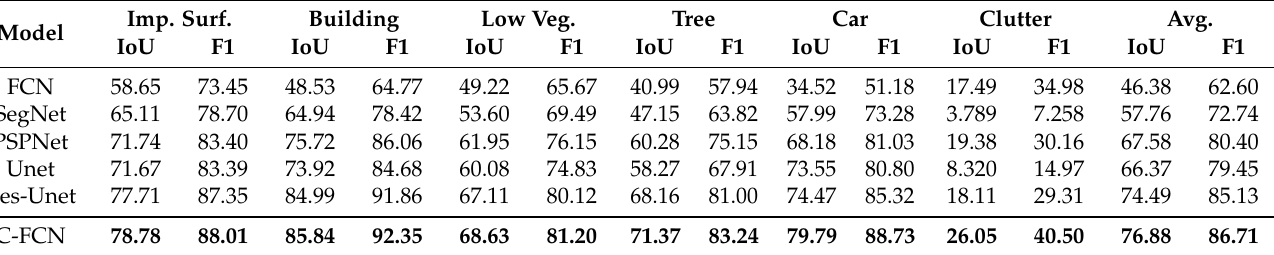
Table 5. Quantitative comparison (%) with baseline models on ISPRS Potsdam challenge test set. Imp. Model